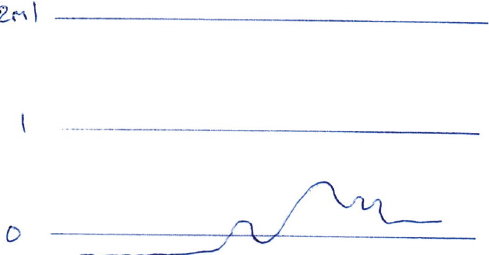
Figure 1: Variations in ear canal volume due to pulsating tympanic